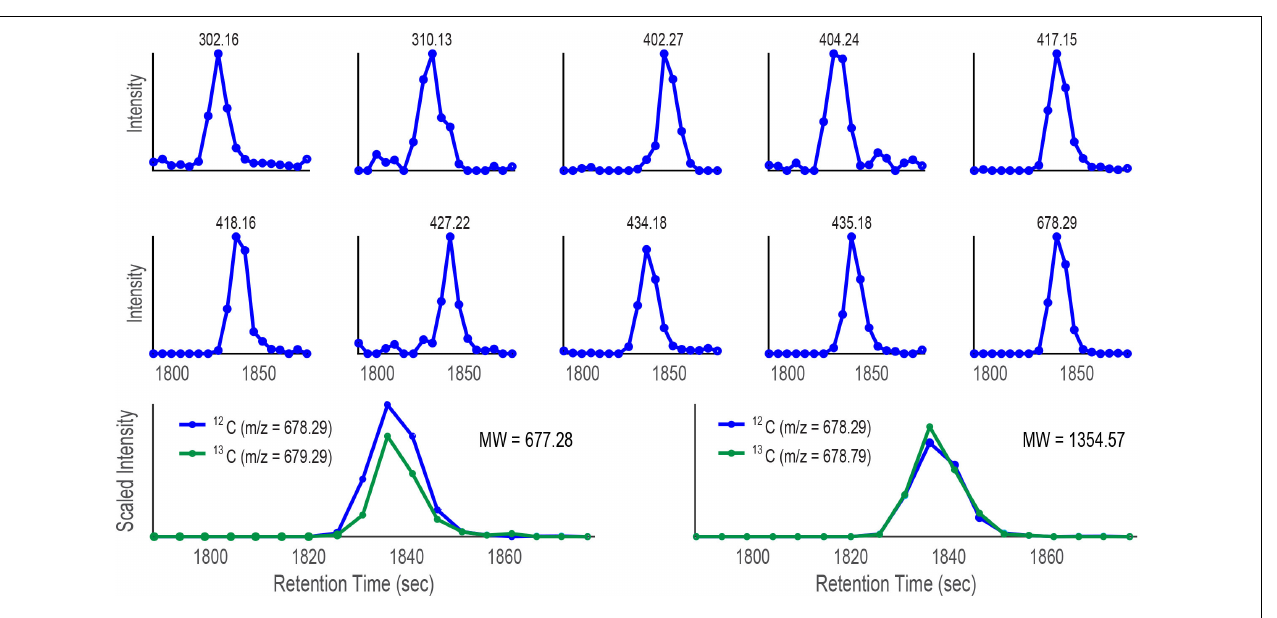
FIGURE 10 | Plots of intensity vs retention time for ten target ions discovered by CMA-T that elute within T w = 3357–3537 s in the SPE organic extract of Prochlorococcus MIT9215 culture media separated by a C18 column. When the target ion 678.29 D is assumed to be singly charged, CMA-C scales the ion at 679.29 D (green trace; 678.29 D+1.003 D, assumed 13 C isotopologue) in each scan by a factor of 3.2 which is overlaid with the EIC of 678.29 D ( 12 C isotopologue, blue trace) in the lower left of the Figure. When the ion 678.29 D is assumed to be doubly charged, CMA-C scales the ion at 678.79 D (green trace, 678.29 D + (1.003 D)/2 = 678.79 D) in each scan by a factor of 1.6, and overlays the result with the EIC of 678.29 D (lower right) . The better fit of 678.79 D plot suggests the ion is doubly charged and that the molecular weight of the 12 C isotopologue is 1354.57 D. TABLE 1 | Targeted ions (D) found by CMA-T from LC-ESIMS dataset with C18 column and Amide column, with overlapping ion bold in